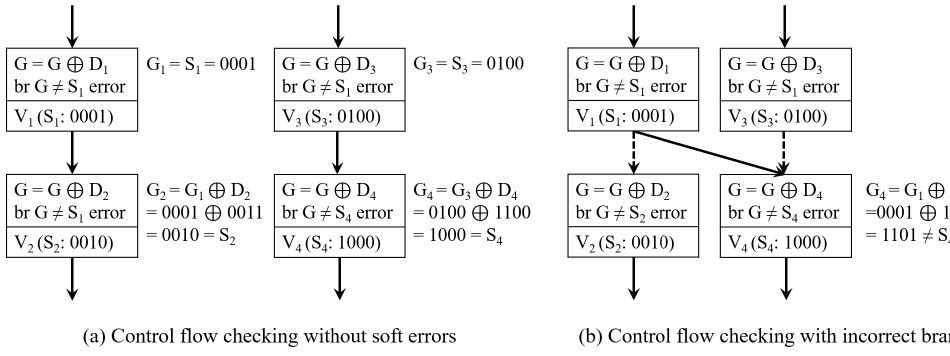
Figure 2. Control flow checking schemes can catch an incorrectly taken branch by using runtime signature and pre-calculated